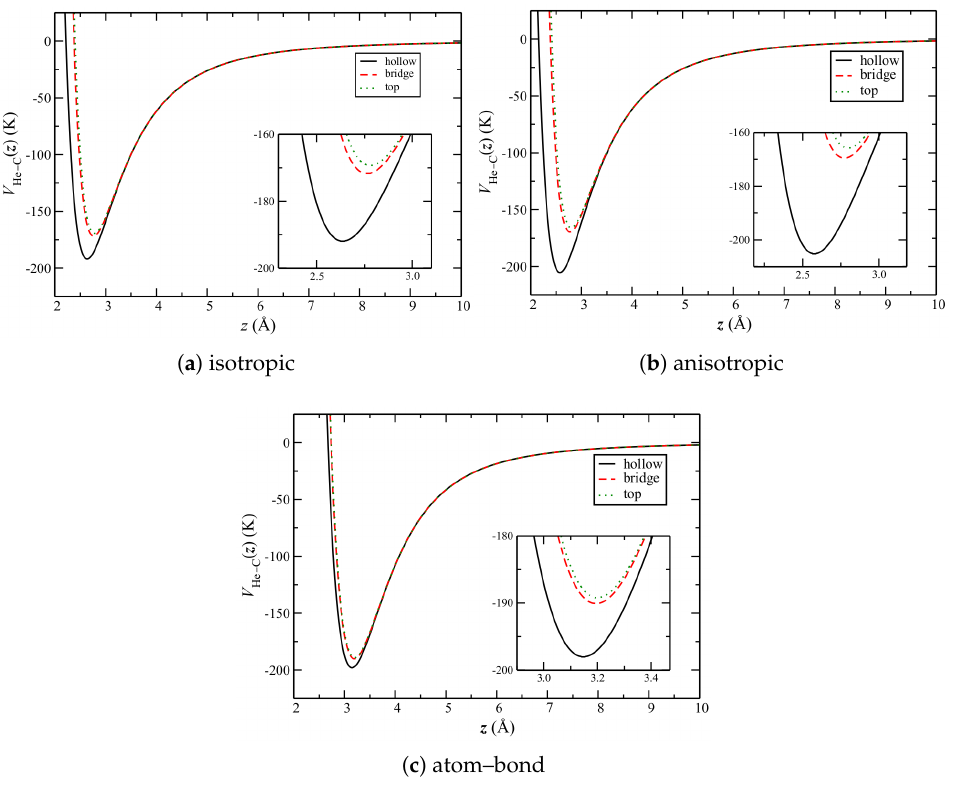
Figure 6. The He–C potential V He–C ( z ) as a function of height z over the three symmetric sites of the graphene plane (Figure 1b). The insets show expanded views of the